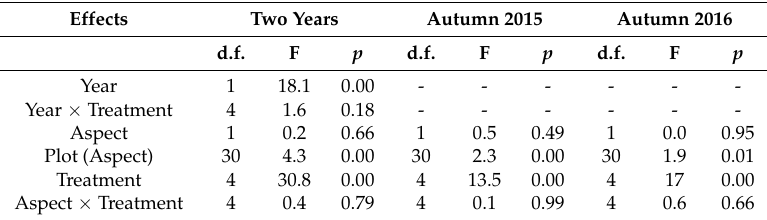
Table 3. Results of the multifactor ANOVA performed to test the statistical significance of each factor included into Equation (2) that relates seedling survival (in log-transformed units) to the predictive factors. The table represents the degrees of freedom (d.f.), F-ratio and p -values ( p ) for the fixed effects (and their interaction) and for the plot effect (random). Effects were considered significant when p -value < 0.05 (95.0% confidence level). Sample data = 160 sub-plots (50 × 50